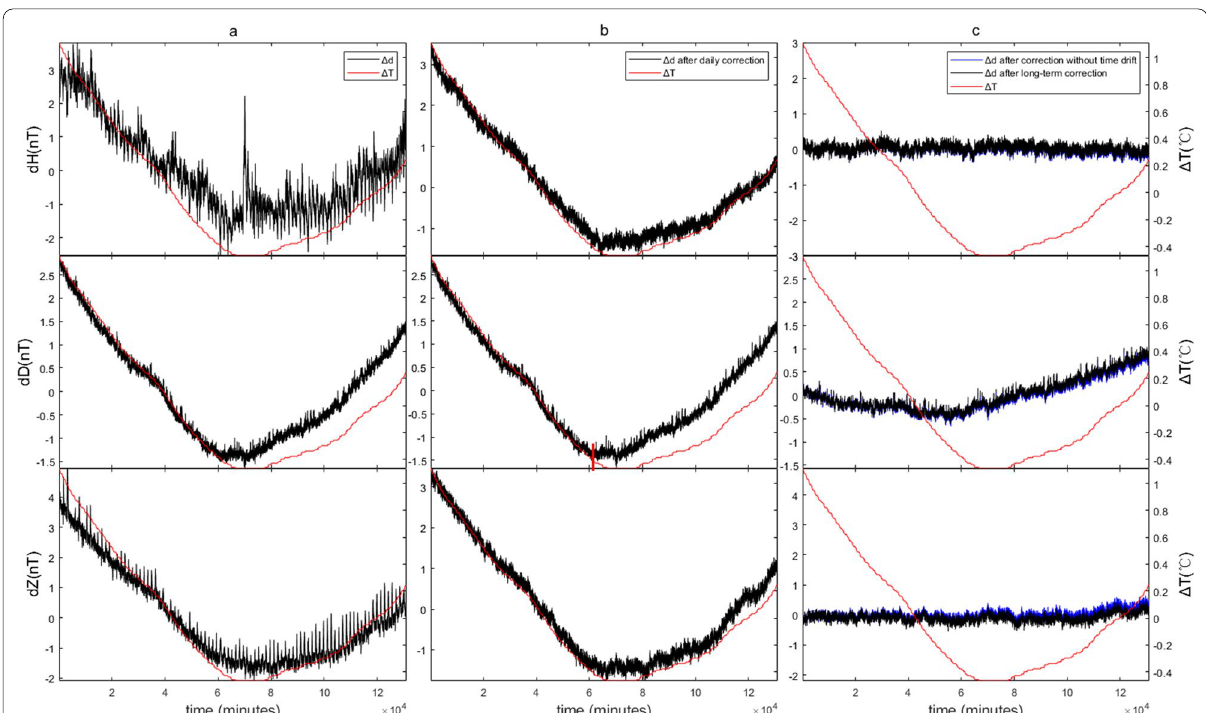
Fig. 6 Long-term-correction effect. a Geomagnetic vector difference during the period of January–March 2020 at the Lijiang (LIJ) observatory before and after the long-term correction. b The geomagnetic vector difference no longer has a significant daily period after the daily correction. c The difference curve tends to level off after the long-term time drift and relative temperature coefficient correction; compared with ( b ), it no longer has significant temperature and time characteristics. In b , after the thick red line, dD is separated from the temperature profile but their trends remain consistent, which is thought to indicate a change in the relative temperature coefficient around the temperature inflection